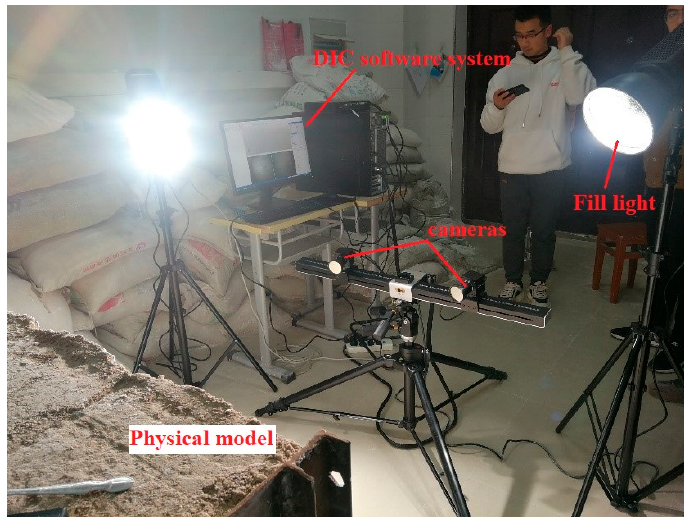
Figure 8. Digital image correlation system.